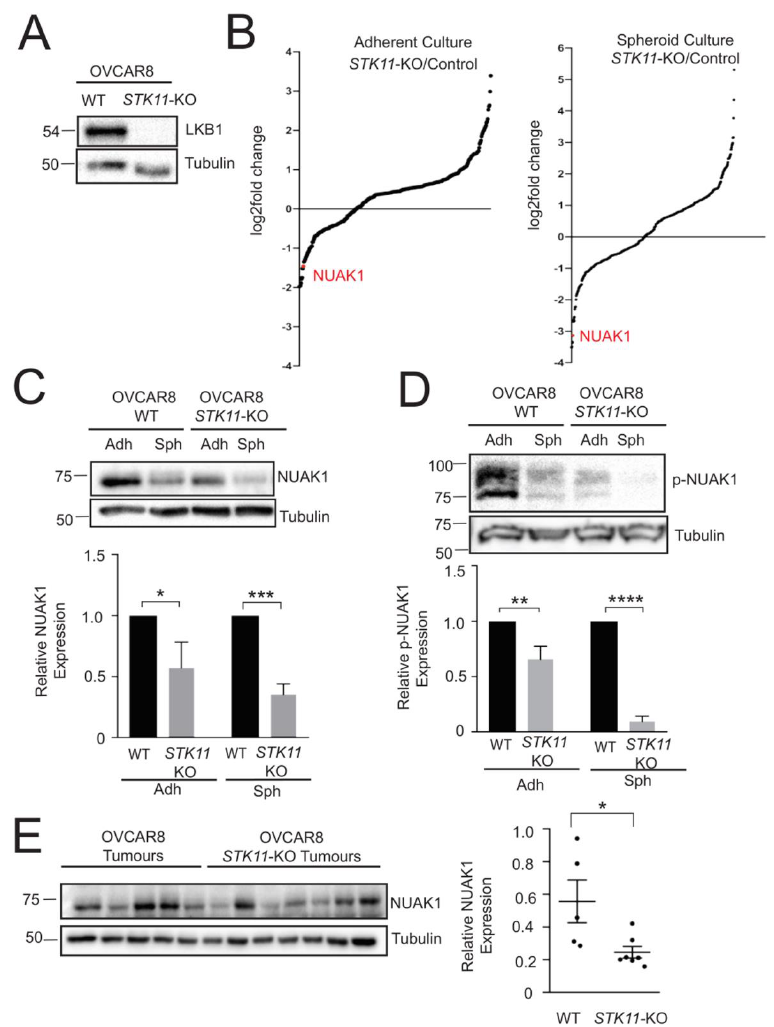
Figure 1. NUAK1 expression is regulated by LKB1 in epithelial ovarian cancer (EOC) spheroids and xenograft tumours. ( A ) Western blot analysis of OVCAR8 parental and OVCAR8- STK11 KO cells to confirm LKB1 loss by CRISPR/Cas9 genome editing. Whole blot images can be found in Figures S1 and S2. ( B ) Multiplexed kinase inhibitor bead-mass spectrometry analysis was completed using OVCAR8- STK11 KO and OVCAR8 cells. Log 2 -fold change of differentially expressed kinases is presented for OVCAR8- STK11 KO versus OVCAR8 cells for adherent and spheroid cultures. ( C ) Immunoblot analysis to determine NUAK1 levels in OVCAR8 and OVCAR8- STK11 KO cells cultured as adherent cells (Adh) or spheroids (Sph) for 72 h. Tubulin was used as a loading control. Densitometric analysis of NUAK1 expression relative to tubulin and normalized to OVCAR8 adherent cells and multiple t -test with Bonferroni correction was performed (* p < 0.05; *** p < 0.001; n = 3). Whole blot images can be found in Figures S3 and S4. ( D ) Immunoblot analysis was completed using Phostag TM acrylamide gels to determine phosphorylated NUAK1 levels in OVCAR8 and OVCAR8- STK11 KO cells cultured as adherent cells (Adh) and spheroids (Sph) for 72 h. Tubulin was used as a loading control. Densitometric analysis of phospho-NUAK1 expression relative to tubulin and normalized to OVCAR8 cells and multiple t -test with Bonferroni correction was performed (** p < 0.01; **** p < 0.0001; n = 3). Whole blot images can be found in Figures S5 and S6. ( E ) Immunoblot analysis of NUAK1 expression in OVCAR8 and OVCAR8- STK11 KO xenograft tumours. Densitometric analysis of NUAK1 expression relative to tubulin for OVCAR8 tumours (n = 5) and OVCAR8- STK11 KO tumours (n = 7). Statistical analysis was performed using two-tailed Student’s t -test (* p < 0.05). Whole blot images can be found in Figures S7 and